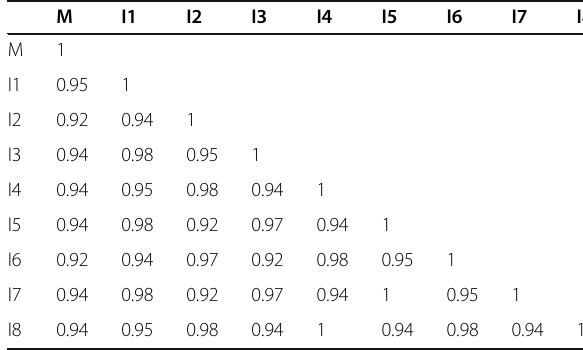
Table 5 Jaccard ’ s similarity coefficient for wild and in vitro regenerated plants of A. pubescens based on ISSR